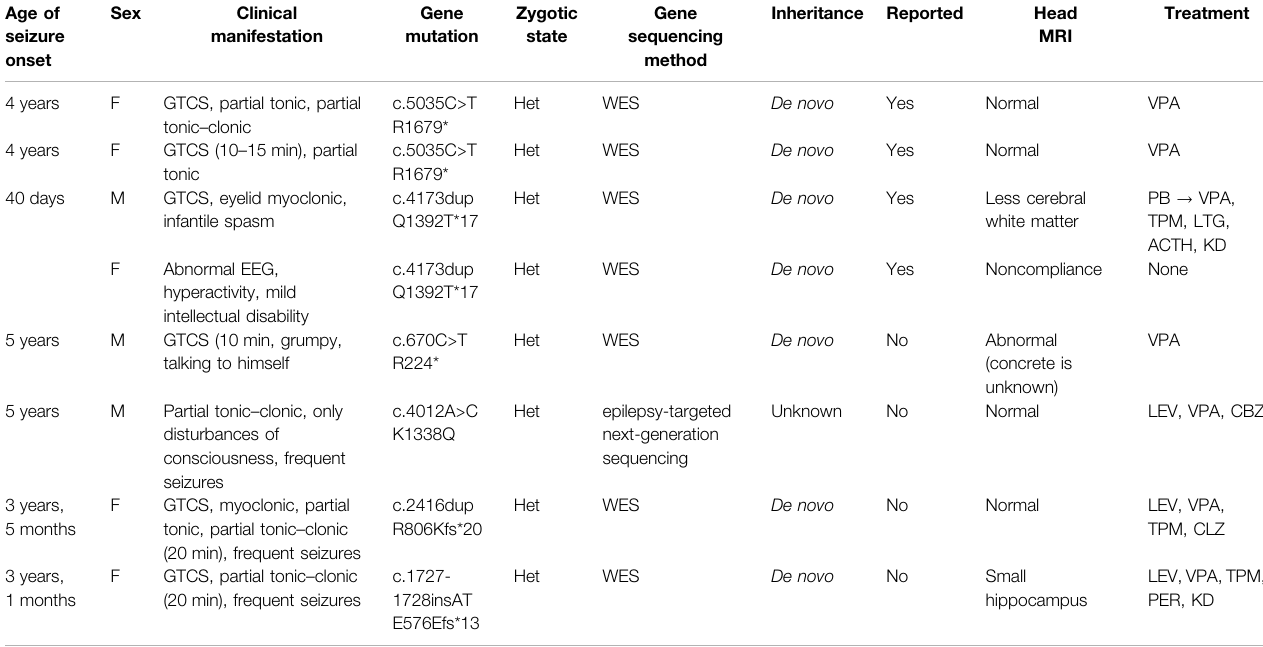
TABLE 1 | Clinical data in this study.